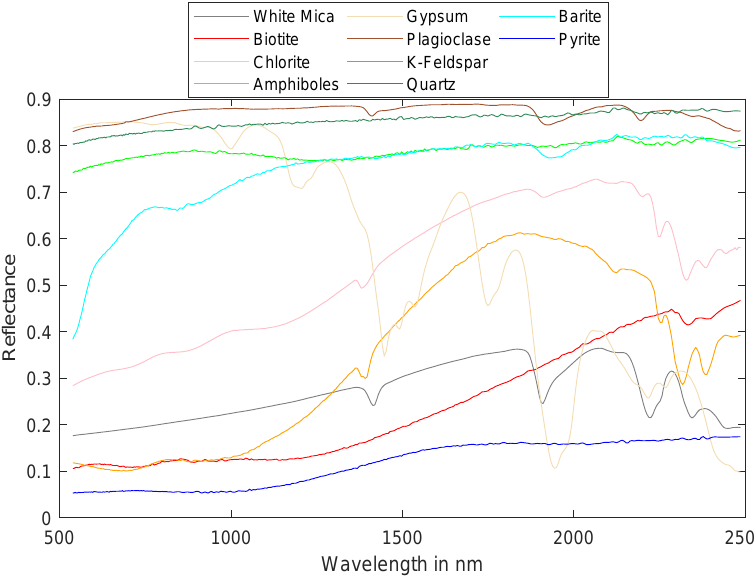
Figure 5. Spectra of ten mineral endmembers from the USGS spectral